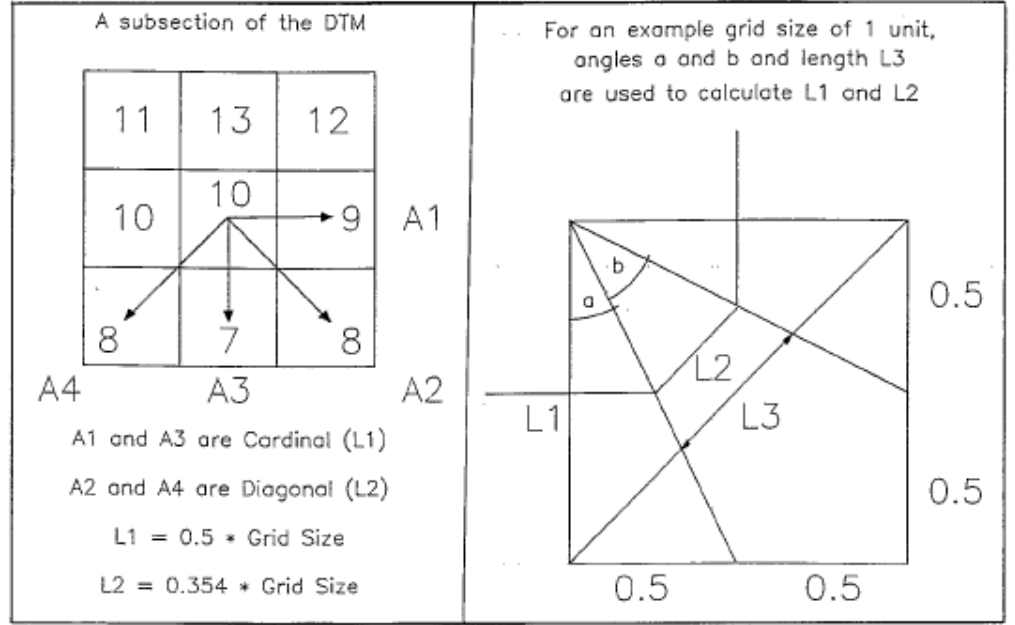
Figure 3: Flow partitioning using a multiple flow direction algorithm (Quinn et al. 1991)